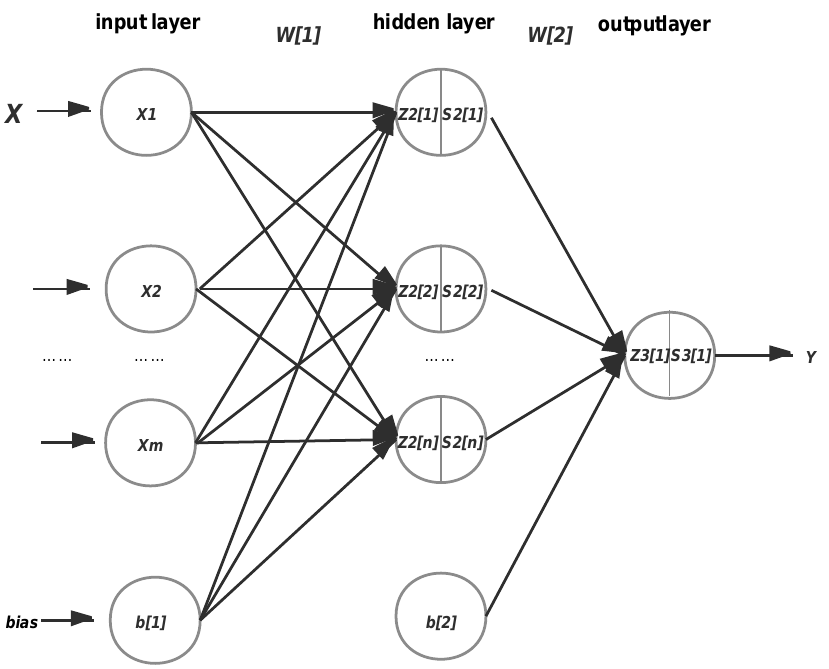
Figure 1. A multilayer perceptron (MLP) artificial neural network, which is a feedforward artificial neural network.